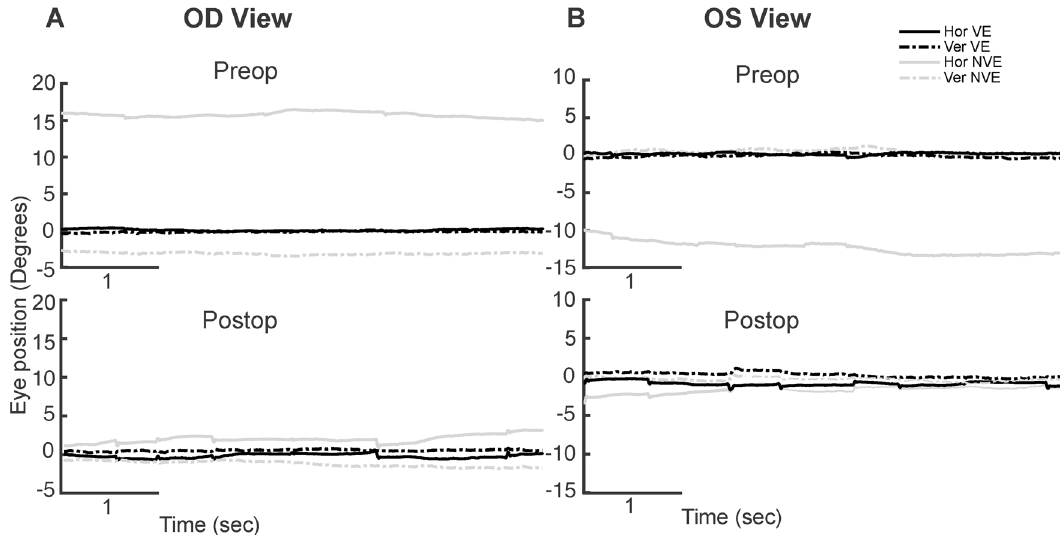
Figure 1. Examples of visual fixation during a 5 s epoch under conditions of monocular viewing from a subject with no nystagmus, pre- and post- strabismus repair during right eye viewing (OD viewing— A ) and left eye viewing (OS viewing— B ), pre- and post- strabismus repair. The x-axis represents time and the y-axis represents horizontal (solid line, black: viewing eye, grey: non-viewing eye) and vertical (dotted line, black: viewing eye, grey: non-viewing eye)